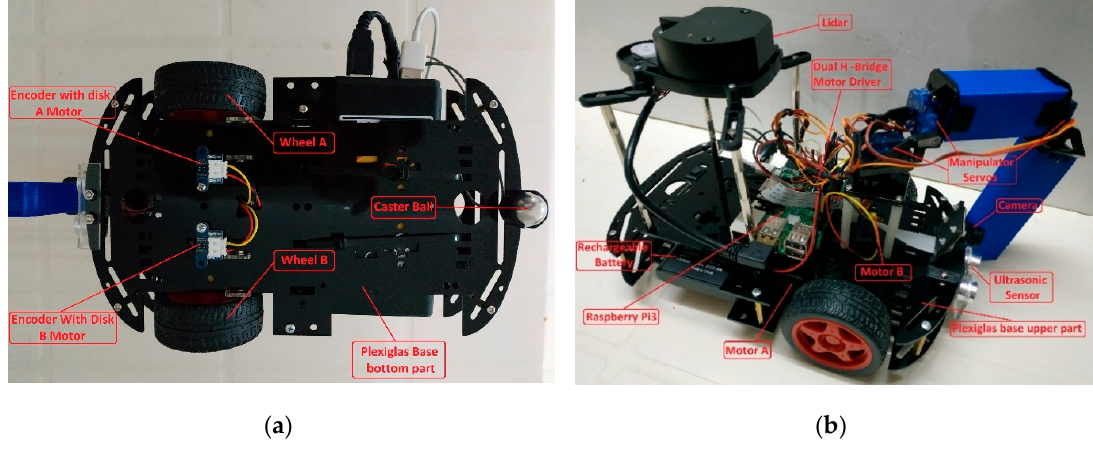
Figure 2. EUROPA and its components; ( a ) Bottom view; ( b ) Side view.